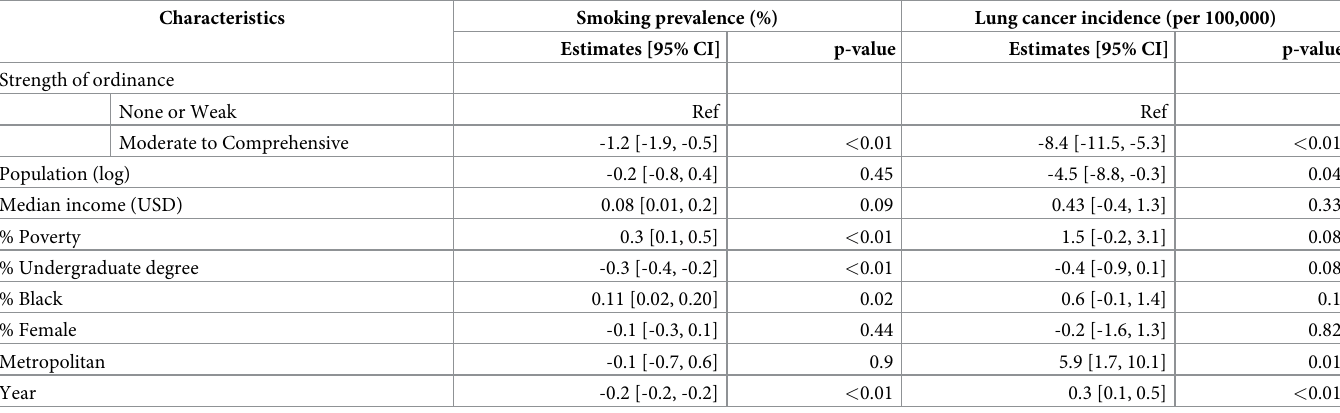
Table 3. Estimated change in smoking prevalence and lung cancer incidence by county-level characteristics